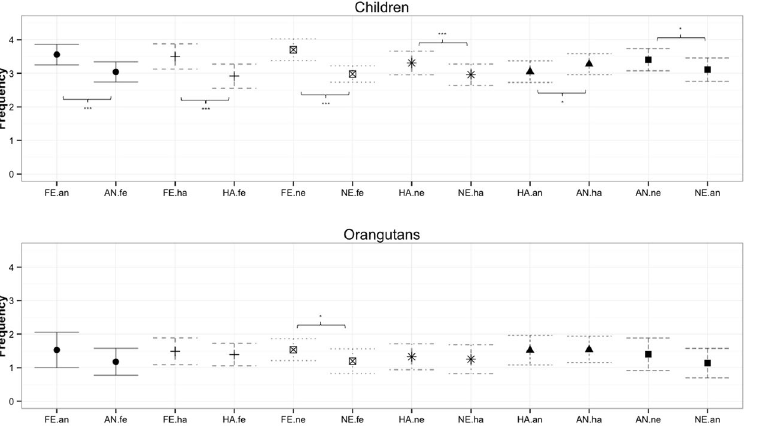
Figure 3. Fixation rates at specific pairs of human facial expressions. Mean estimates for the fixation rate for each target emotion (in capital letters, e.g. “FE”) compared to a specific distractor emotion (lower case letters, e.g., “an”) for human children and orangutans. The corresponding combinations (e.g., FE.an and AN.fe) are depicted by the same symbols and lines. fe = fear, an = anger, ha = happy, ne = neutral. Significant comparisons are indicated by asterisks ( > 0.01 * ; > 0.05 ** ; > 0.01 *** Study 2: Gaze patterns at orangutan facial expressions.